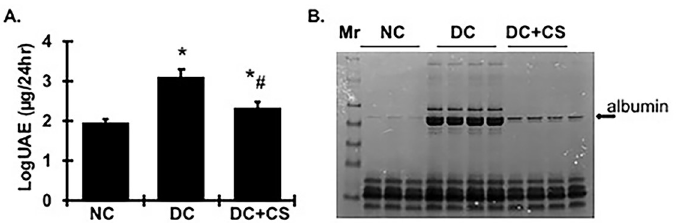
Figure 3. rBMSC sheets improve proteinuria in CGN rats. ( A ) log10-transformed urinary albumin excretion (UAE, µg/24 h) values. * vs. normal control rats (NC), p < 0.05; # vs. disease control rats DC, p < 0.05. DC + CS, diseased rats received rBMSC sheets transplantation. ( B ) SDS-PAGE electrophoresis of 24 h urine samples. Mr. protein markers.